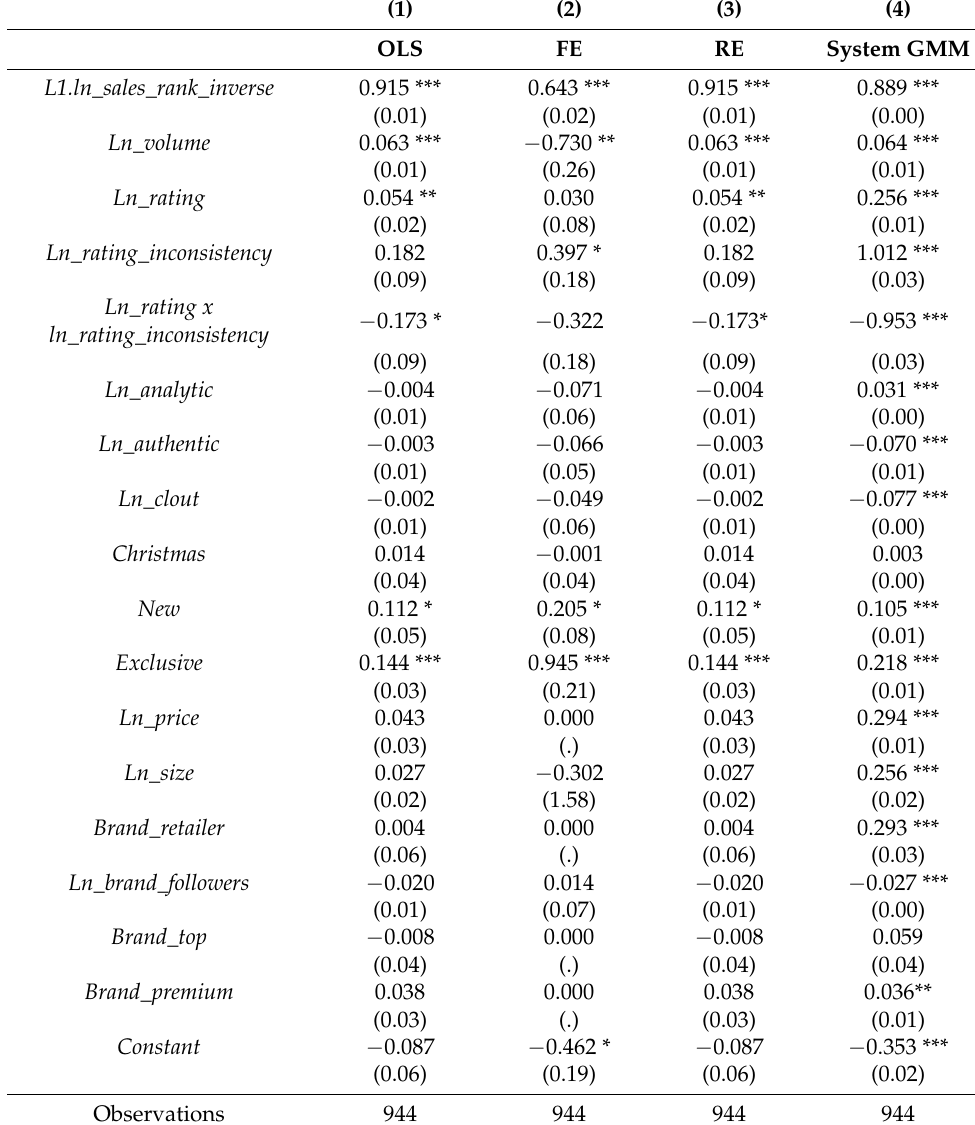
Table 5. Most helpful visibility—all reviews, decreasing probability of being viewed (case v 2.1